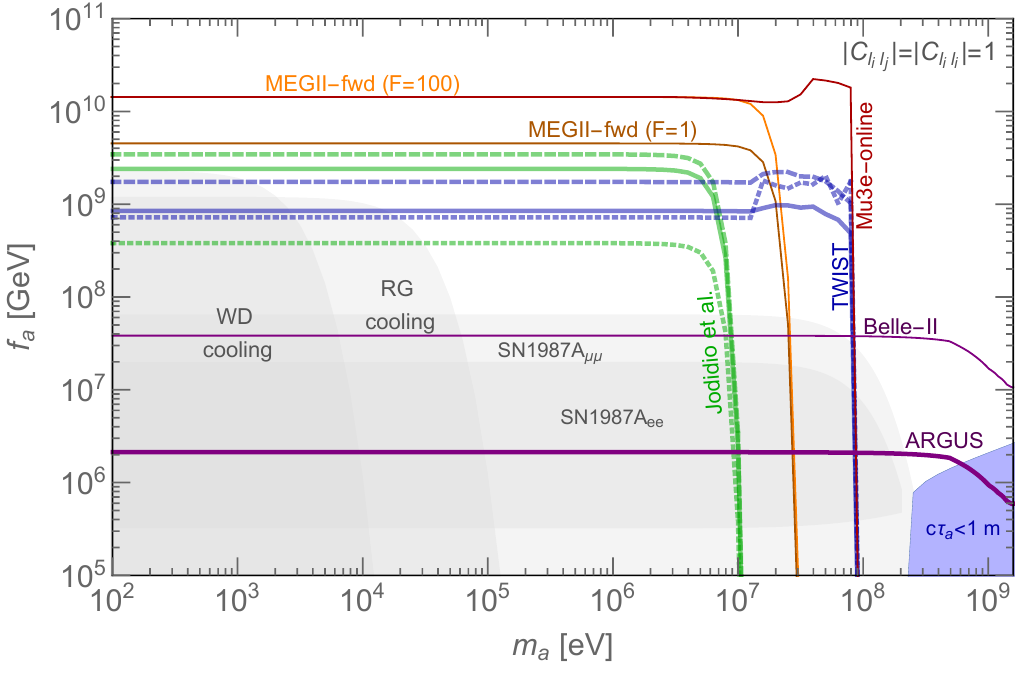
Figure 1 . Summary of the present bounds and future projections for an ALP with generic couplings to leptons, i.e., we set C V = C A = 1 for all the couplings in eq. (2.1). For the isotropic case we ‘‘ 0 ‘‘ 0 set C V = 0 and C A = 1 (the opposite choice leads to the same results). In the V ± A case we µe µe set C V = ± C A = 1 . The gray shaded regions are excluded by the astrophysical bounds from µe µe star cooling due to C A and by SN1987A due to C A and C A , see section 6.1. We present these ee ee µµ bounds for the isotropic case. The blue shaded region corresponds to a prompt/displaced ALP. The green solid line is the exclusion due to the bound on µ + → e + a by Jodidio et al., assuming an isotropic ALP [9]. The green dotted (dashed) line is our recast of this bound for the V − A ( V + A ) case. The sensitivity in the V − A case is worse since then the signal is suppressed in the forward direction as much as the background. The blue solid (dotted, dashed) lines are the bounds from the TWIST experiment on isotropic ( V − A , V + A ) ALP [10]. The dark orange thin solid line is the MEGII-fwd projection for an isotropic ALP with no magnetic focusing while for the orange thin solid line we assumed that focusing increases the luminosity in the forward direction by a factor of 100, cf. section 3.2 for details. The dark red thin solid line is the Mu3e projection from [42], for the isotropic ALP. The sensitivity for the other chiral structures is expected to be similar since there is no background suppression in this setup. The purple solid line is the bound from the τ → µa search by the ARGUS collaboration [43], and does not dependent on the chirality of the ALP couplings. The purple thin line is the projected reach at Belle-II, see section 5 for details. The bound on µ + → e + aγ from Crystal Box is subdominant, see section 4, and is not